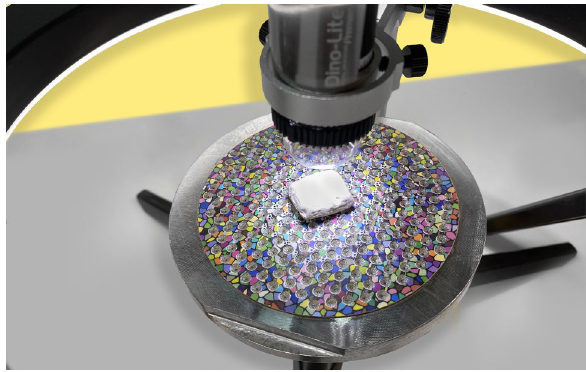
Figure 3 . Three-dimensional calibrated plate combined with the digital microscope (updated